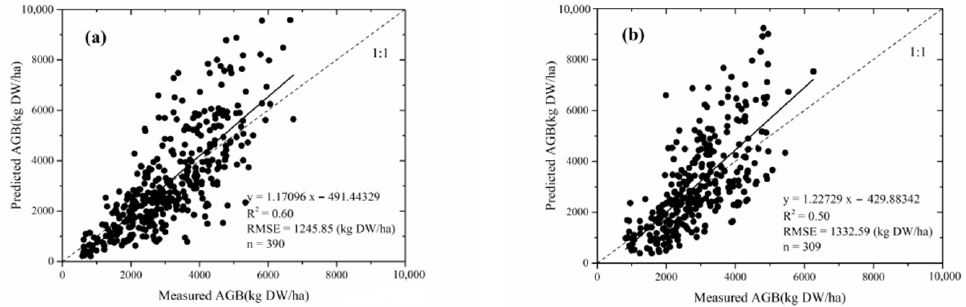
Figure 3. ( a ) Relationship between the measured biomass by RF-SRA vad and that predicted by it. ( b ) Relationship between the biomass measured using the RF-SRA indep and that predicted by it.